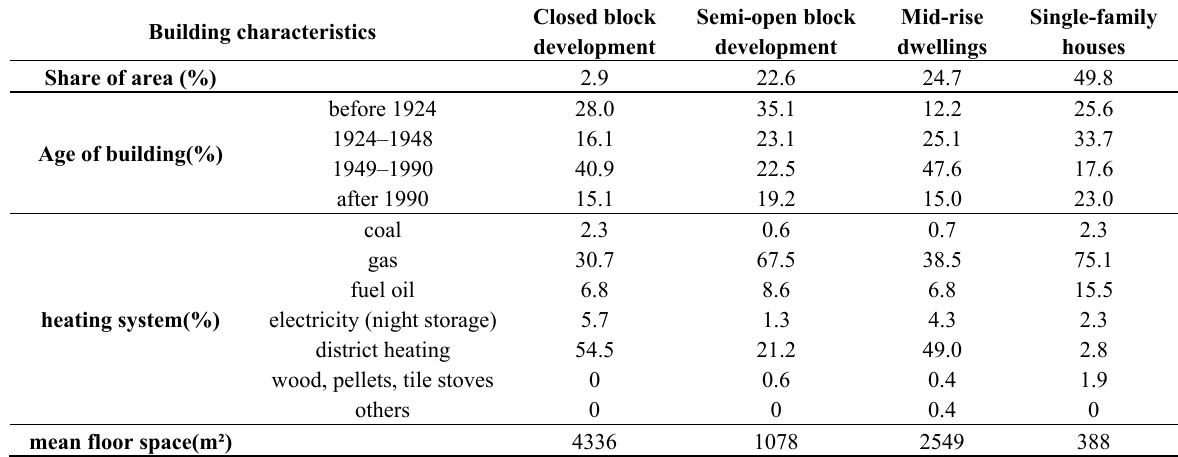
Table 4. Building characteristics of the four urban structure types in